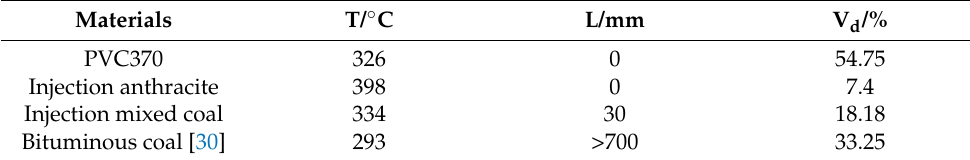
Table 5. Results of explosiveness of carbonaceous